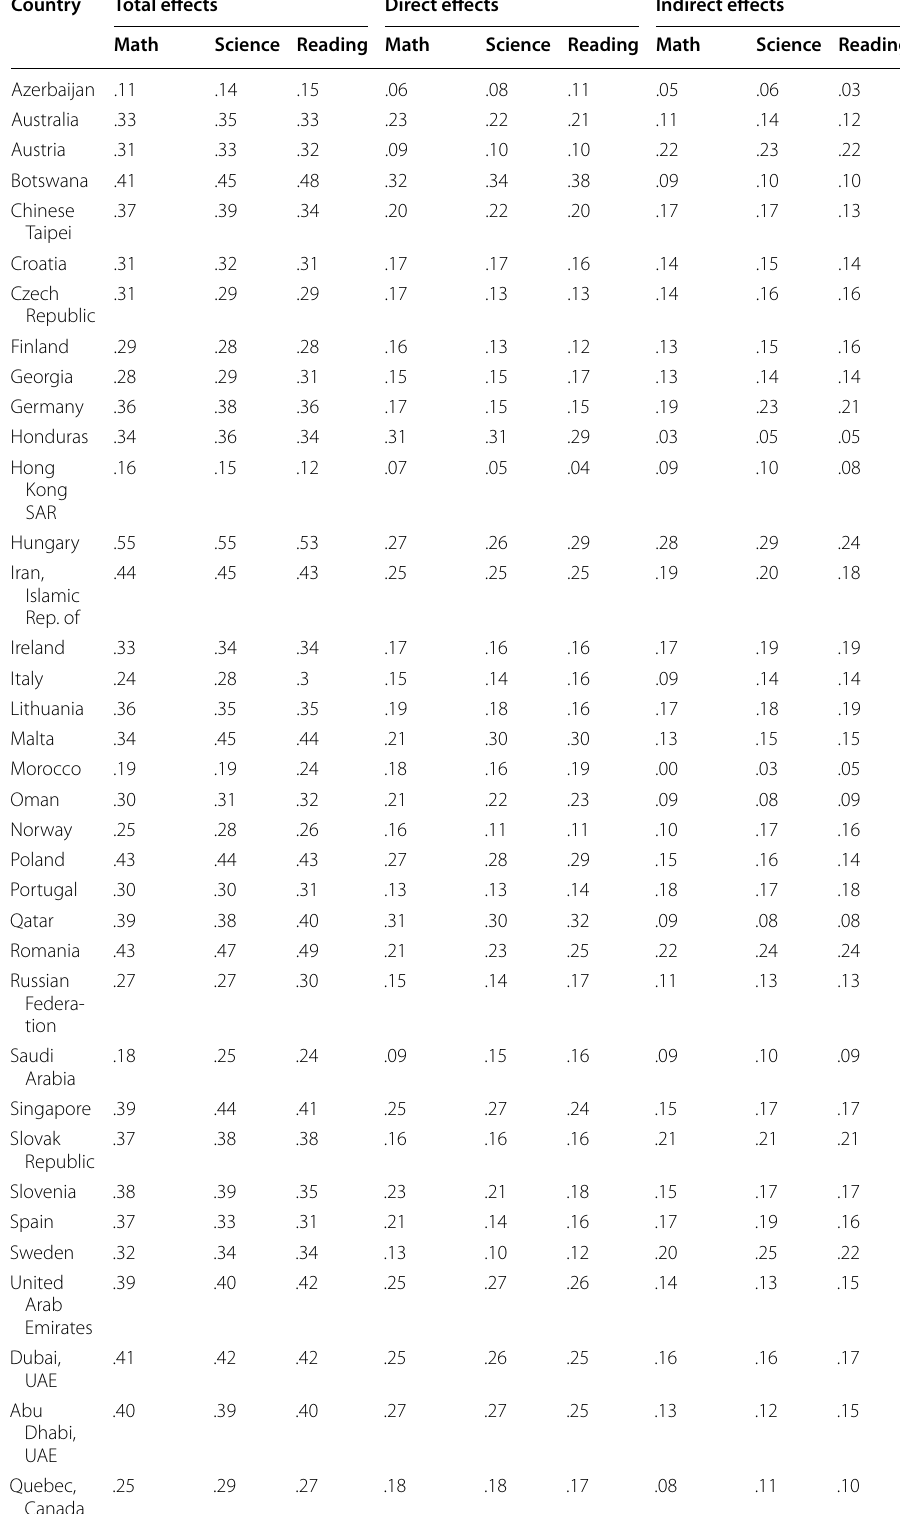
Table 1 Estimates of total, direct and indirect